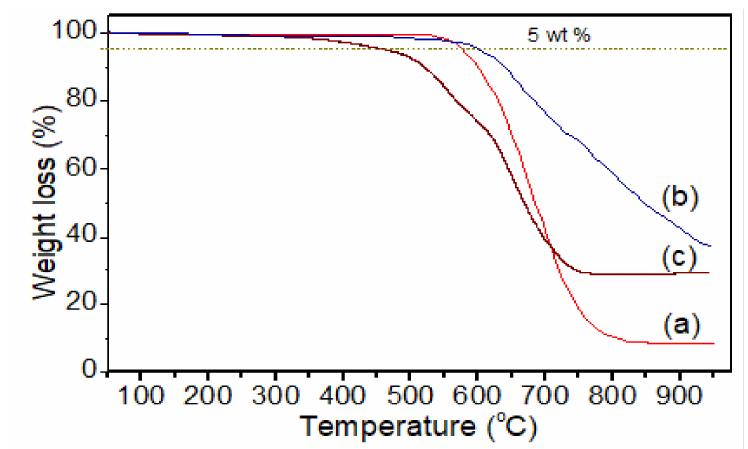
Figure 7. Thermal analysis of ( a ) pure PI, ( b ) PI-TSi, and ( c ) PI-TSi-GPMS50